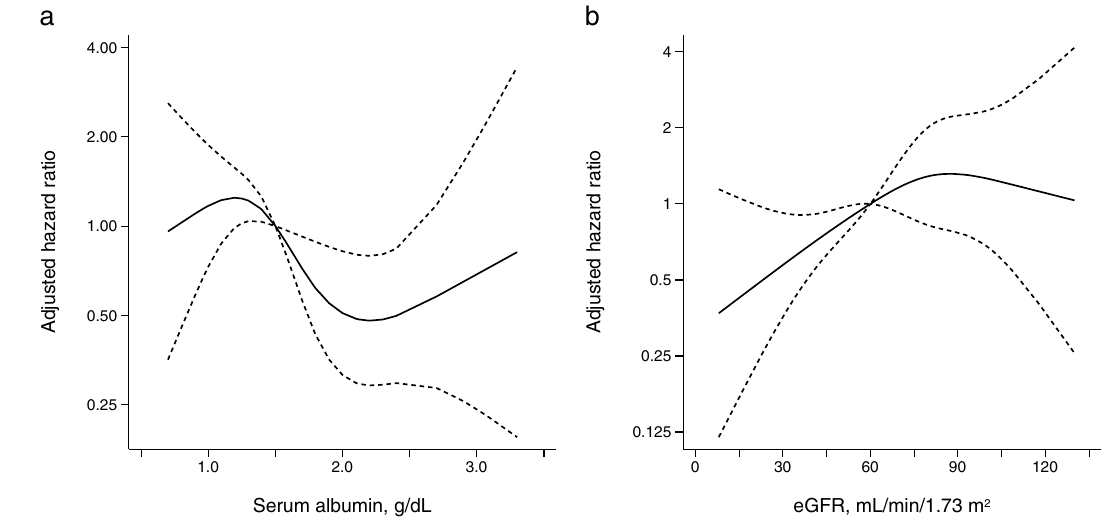
Figure 2. Restricted cubic spline curve for the association of serum albumin ( a ) and eGFR ( b ) with remission, adjusted for age (18–40, 41–64, and ≥ 65 years), sex, body mass index (kg/m 2 ), systolic blood pressure (mmHg), urinary protein (g/day or g/gCr), eGFR (mL/min/1.73 m 2 , if serum albumin), serum albumin concentration (g/dL, if eGFR), dipstick hematuria (− or ± , 1+, and ≥ 2+), and intravenous albumin administration at initiating IST; and use of intravenous methylprednisolone and cyclosporine within one month after initiating immunosuppressive